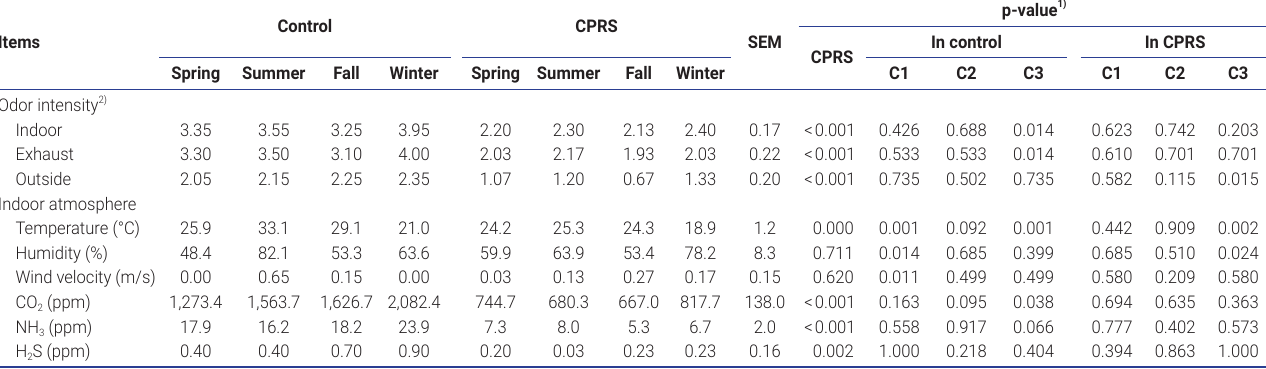
Table 4. Comparison of odor intensity and atmospheric characteristics in the finishing pigsty based on to continuous pit recirculation system (seasonal) Control CPRS Items